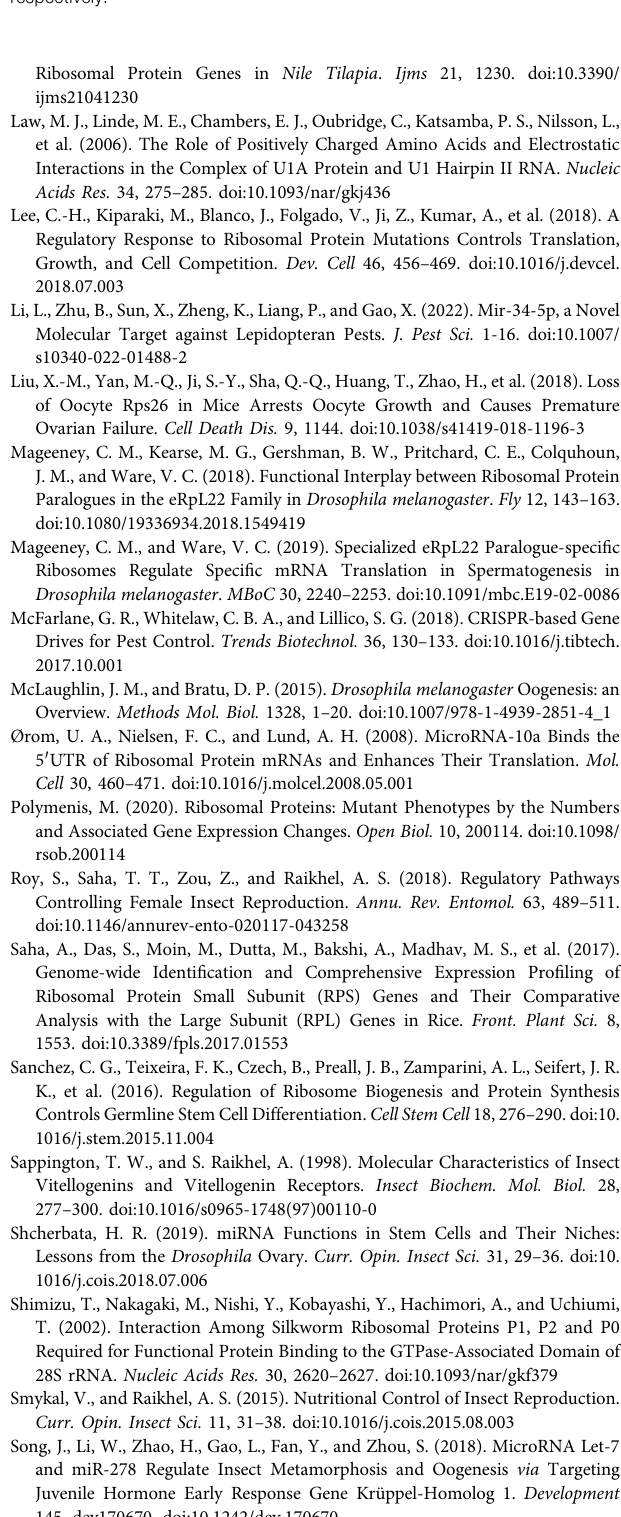
Supplementary Figure S2 | A network diagram of the regulatory relationships between the presumed miRNAs and particular SlRp genes. (A – C) showed three representative regulation networks for mir-137-2, RPSA and RPS25 ,